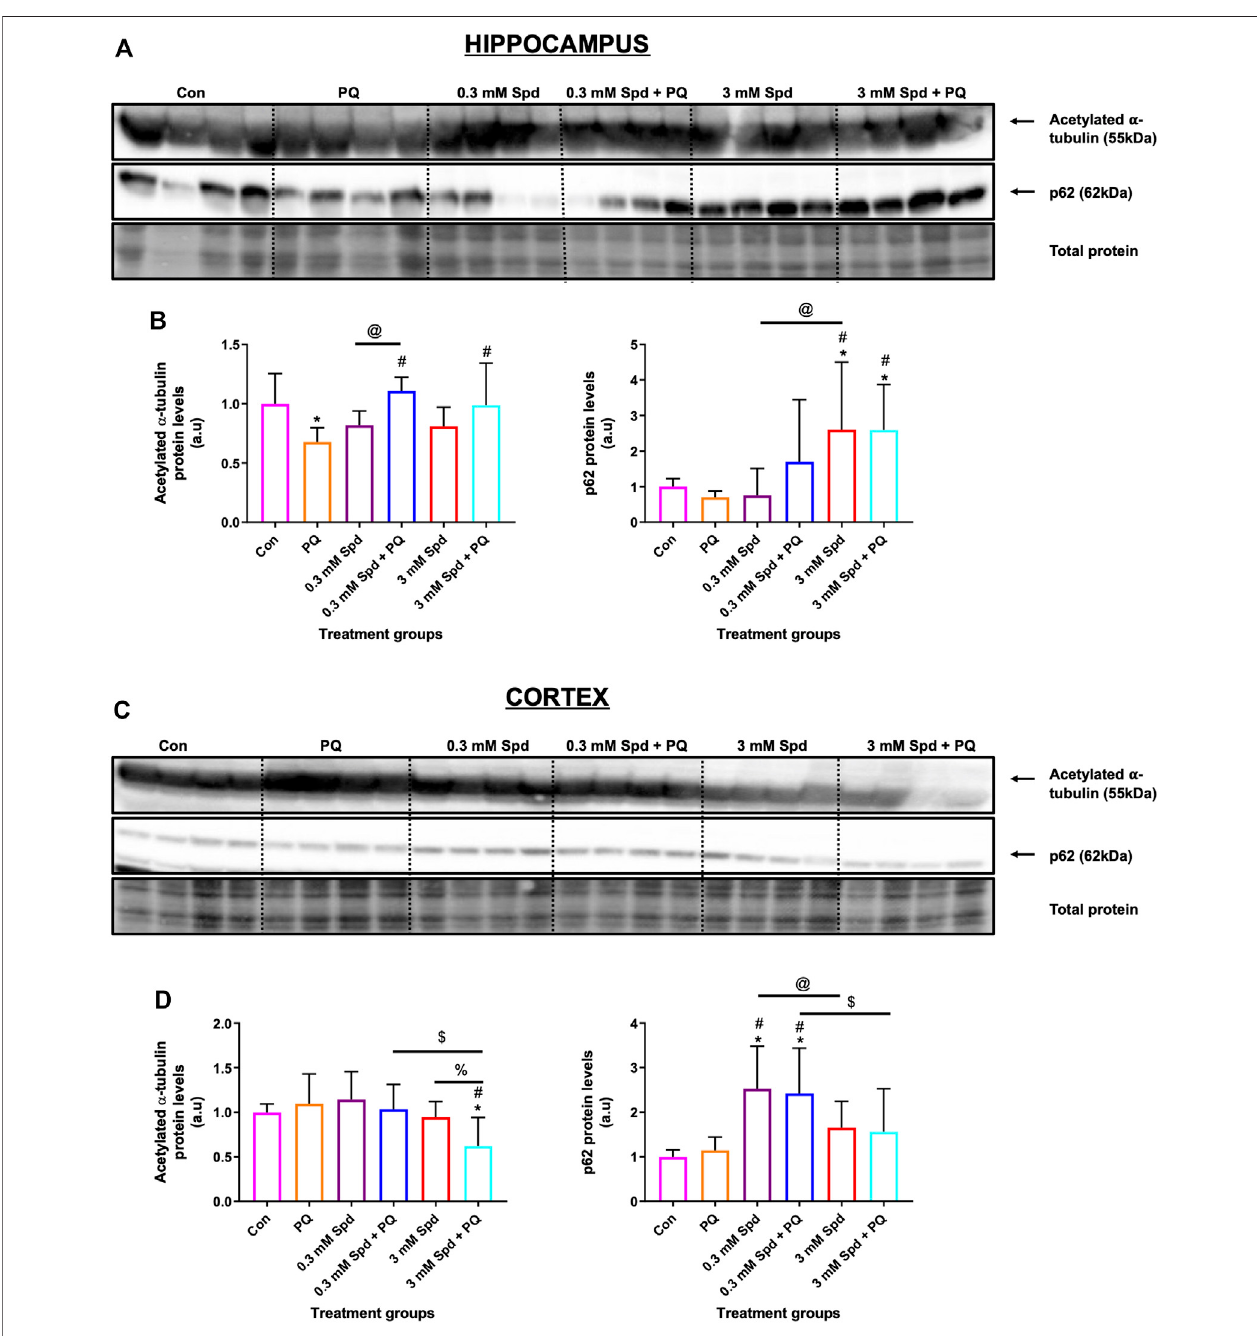
FIGURE 11 | Differential effect of spermidine on tubulin acetylation and autophagic activity in the hippocampus and cortex. (A,B) Representative western blot and densitometric analysis of acetylated α -tubulin and p62 protein levels in the hippocampus and (C,D) cortex. The data are expressed as mean ± SEM. A total of 6 – 10 animalswereusedpergroup( n =6 – 10).SpermidineincombinationwithPQincreasedacetylated α -tubulinandp62comparedtoPQtreatedgroupinthehippocampus. In the cortex region, combination treatment of the low concentration spermidine increased p62 protein levels, while co-treatment with the high concentration of spermidine decreased acetylated α -tubulin with no effect on p62 levels. * = p < 0.05 vs. control, # = p < 0.05 vs. PQ, @ = p < 0.05 vs. 0.3 mM Spd, $ = p < 0.05 vs. 0.3 mM Spd + PQ and % = p < 0.05 vs. 3 mM Spd, arbitrary units (a.u).